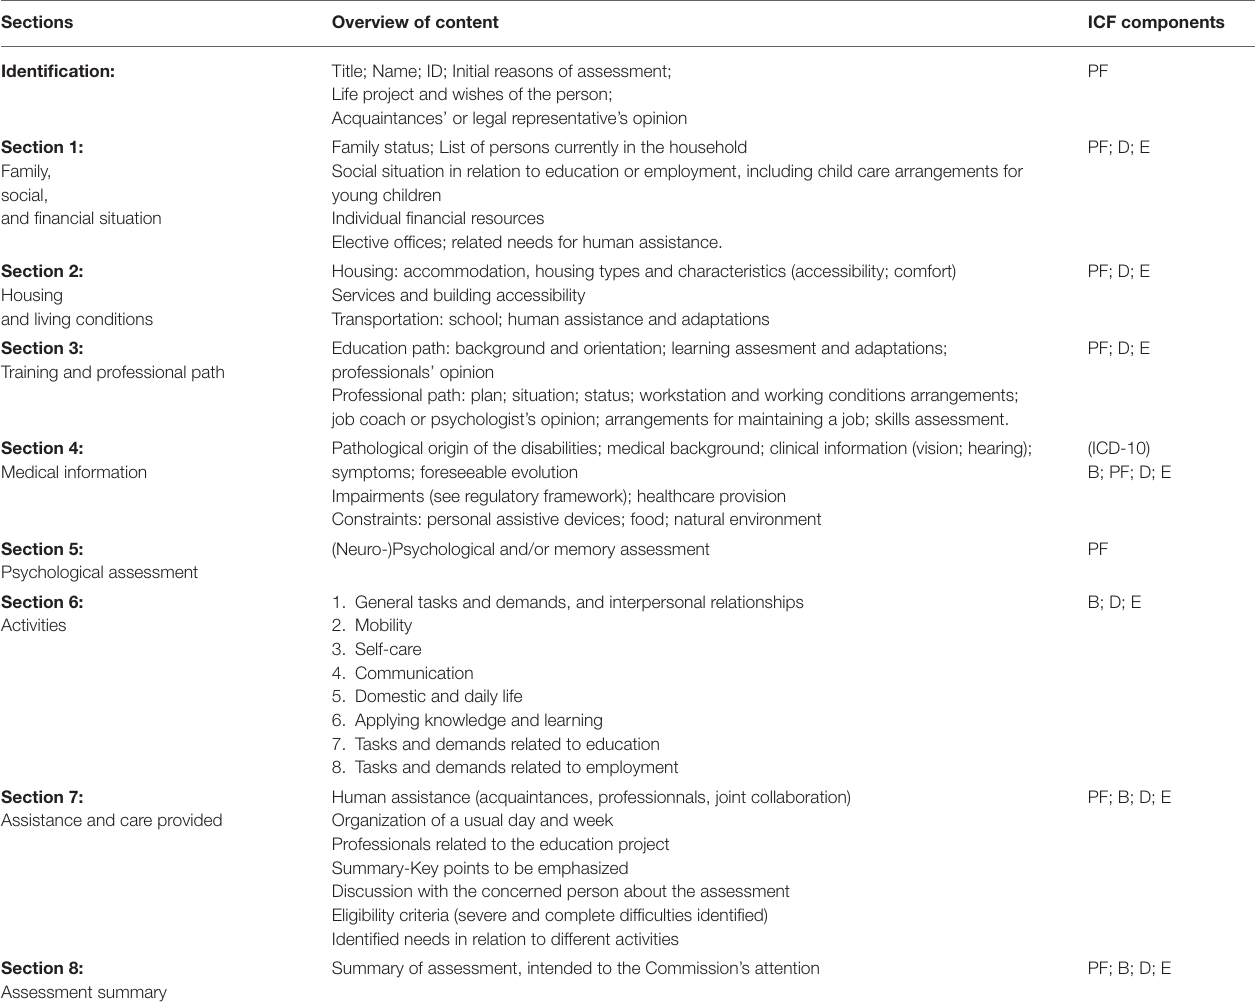
TABLE 1 | Overview of the GEVA 2008 sections and corresponding covered ICF components.